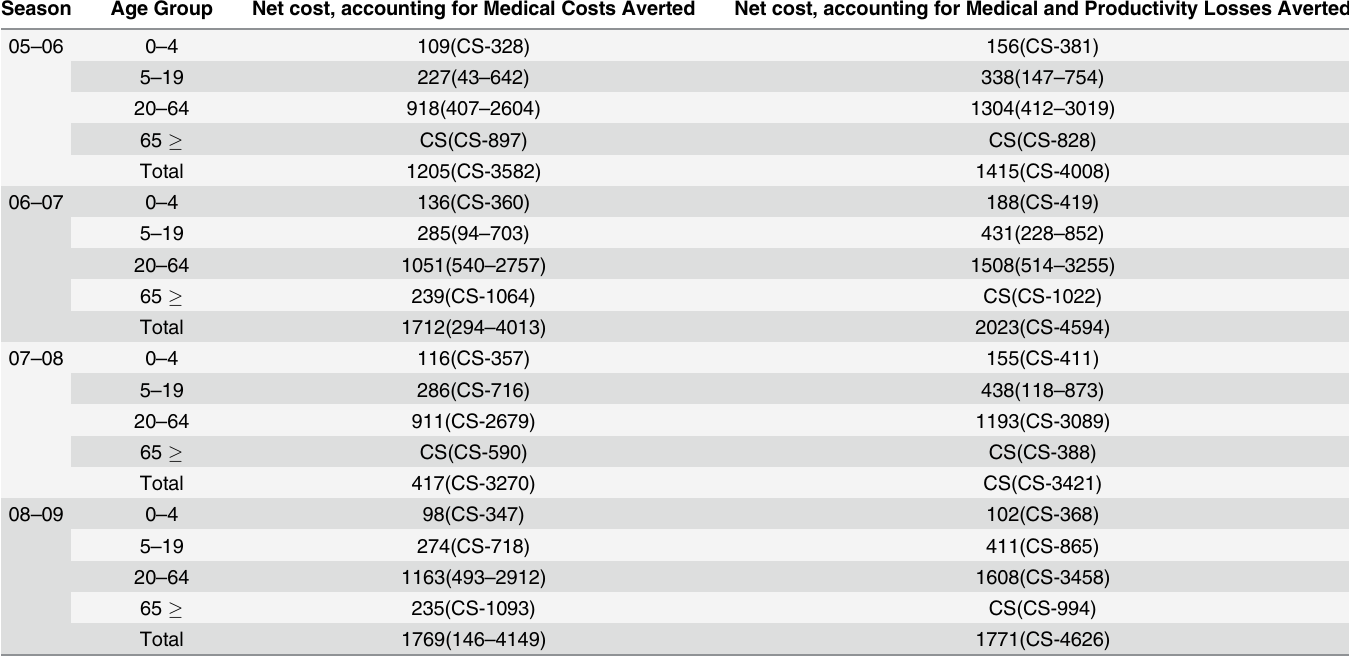
Table 4. Net costs of the U.S. influenza vaccination program (in millions), by age group and season: mean values and 95% empirical confidence intervals.